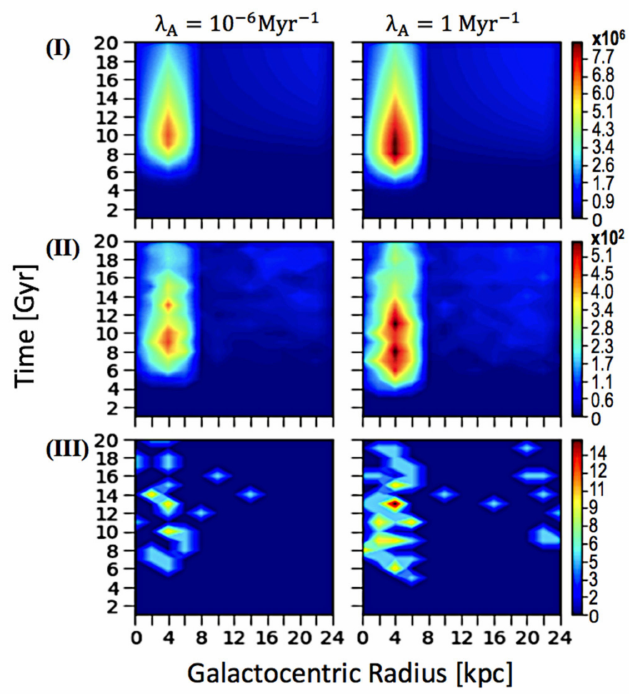
Figure 3. The sterilizing SNe spatial–temporal profiles ( I ) P ann = 0, ( II ) P ann = 0.5, ( III ) P ann = 0.99. Color bar represents the number of sterilized ETI from